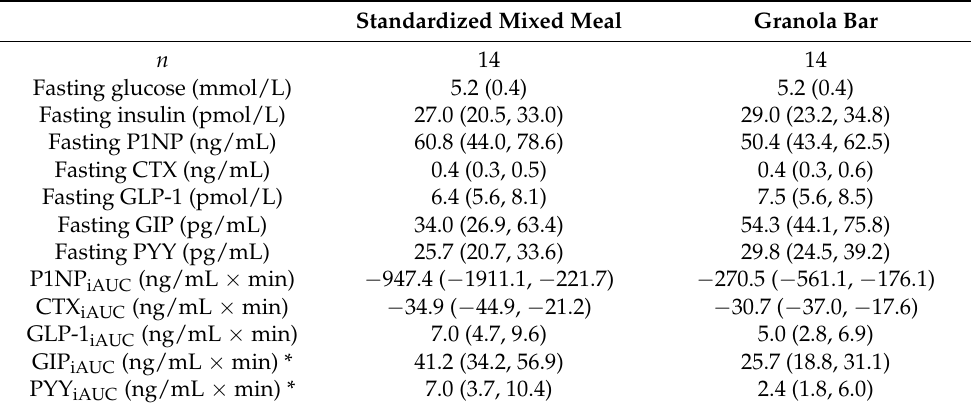
Table 2. Plasma concentrations of glucose, insulin, gut hormones, and bone markers in the study population during the two study days for each meal